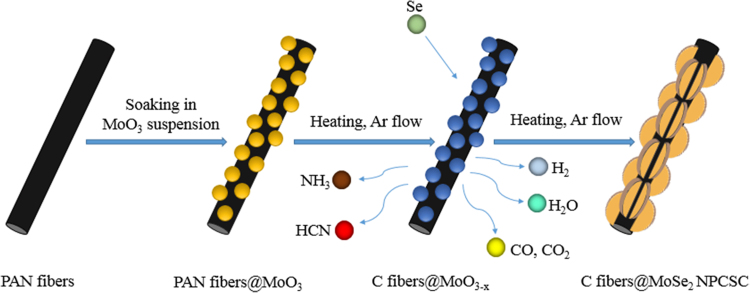
Formation mechanism of the C fibers@MoSe2 NPCSC.